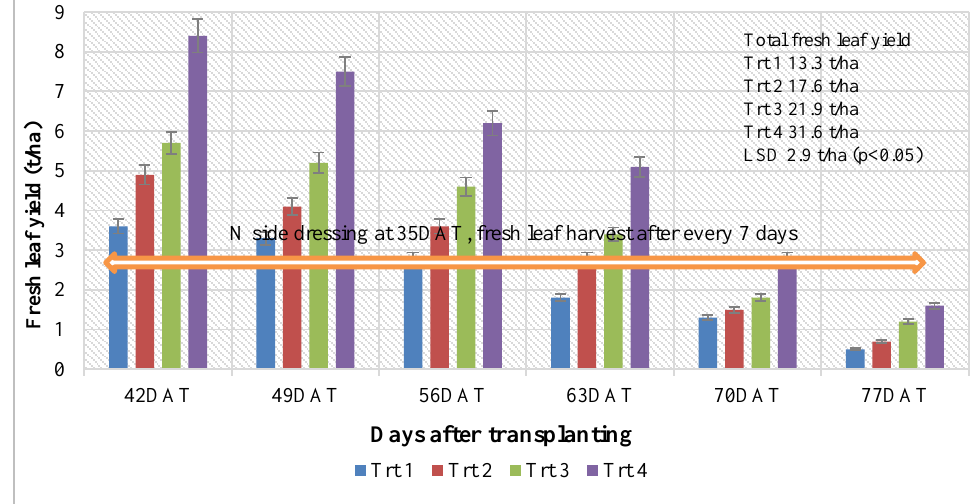
Figure 3a . Fresh rape leaf yield responses over the growing seasons after N fertilizer applications (2014)